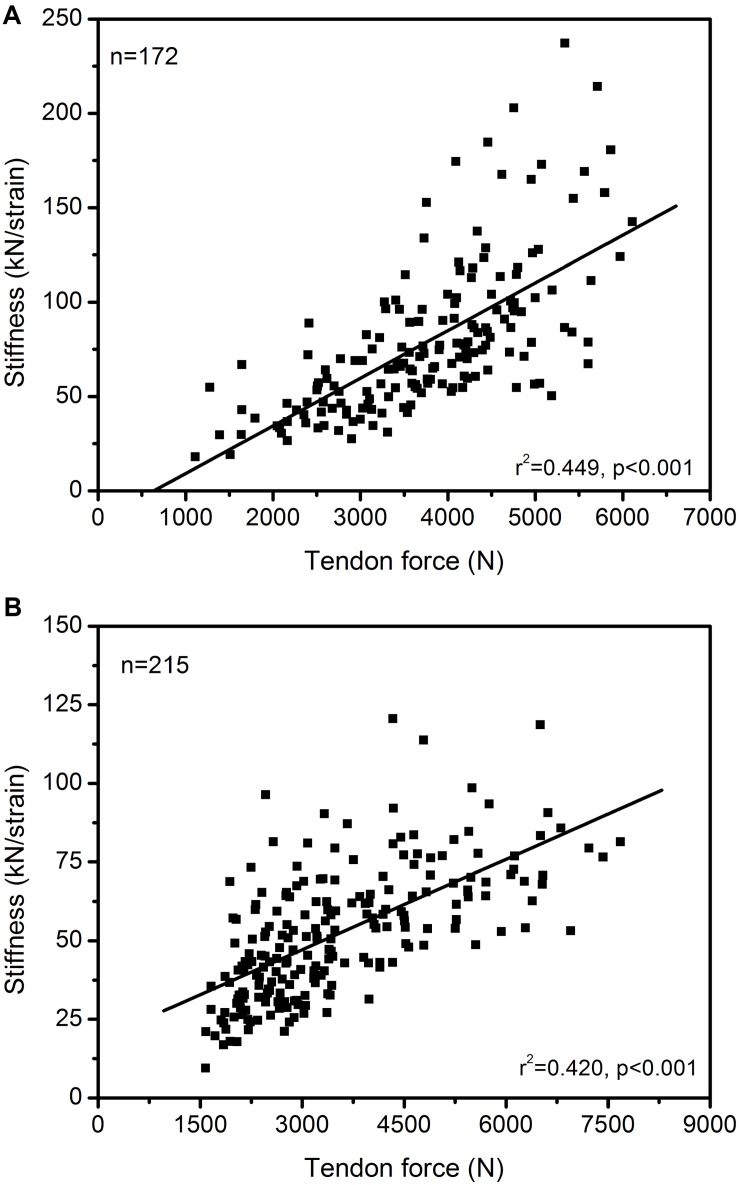
Association between in vivo Achilles (A) and patellar (B) tendon force and tendon stiffness (normalized to tendon rest length) in 172 and 215 athletes from different sports (endurance running, sprinting, ball sports, diverse) and untrained individuals, including data from adolescents and adults. The Pearson correlation coefficients and 95% confidence intervals [lower limit, upper limit] were 0.670 [0.578, 0.745] and 0.648 [0.563, 0.719] for the Achilles and patellar tendon, respectively. The presented data is from earlier studies of our group (A: Arampatzis et al., 2007a, b, 2010; Stafilidis and Arampatzis, 2007; Albracht and Arampatzis, 2013; B: Charcharis et al., 2019; Mersmann et al., 2019) as well as yet unpublished work (A: n = 26; B: n = 118).